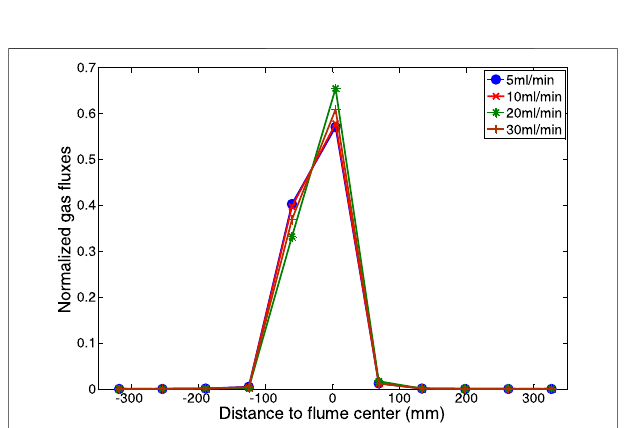
FIGURE 8 | The bubble plume lateral width evolution with its standard deviation (inset